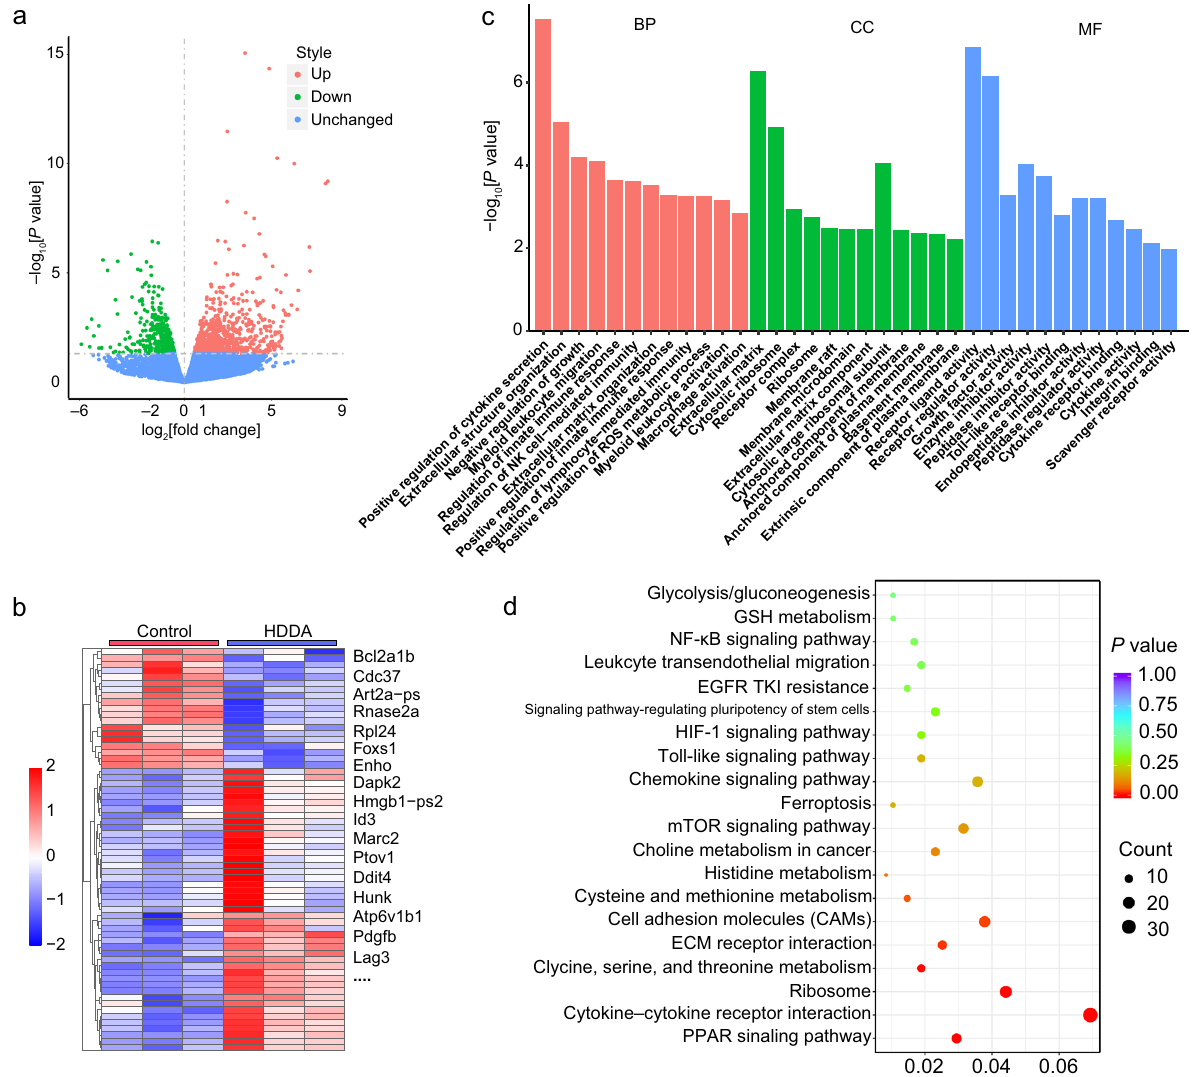
Fig. 6 | Transcriptomic analysis of 4T1 tumor tissues after HDDA treatment. a Volcano plot of allDEGsbetween the control groupand the HDDAgroup. b Heat map of the selected DEGs between the control group and the HDDA group. Red: upregulation;blue:downregulation;falsediscoveryrate<0.05.SomekeyDEGsare listed on the right of the map. c Histogram showing the GO enrichment analysis results of some selected DEGs between the control group and the HDDA group.